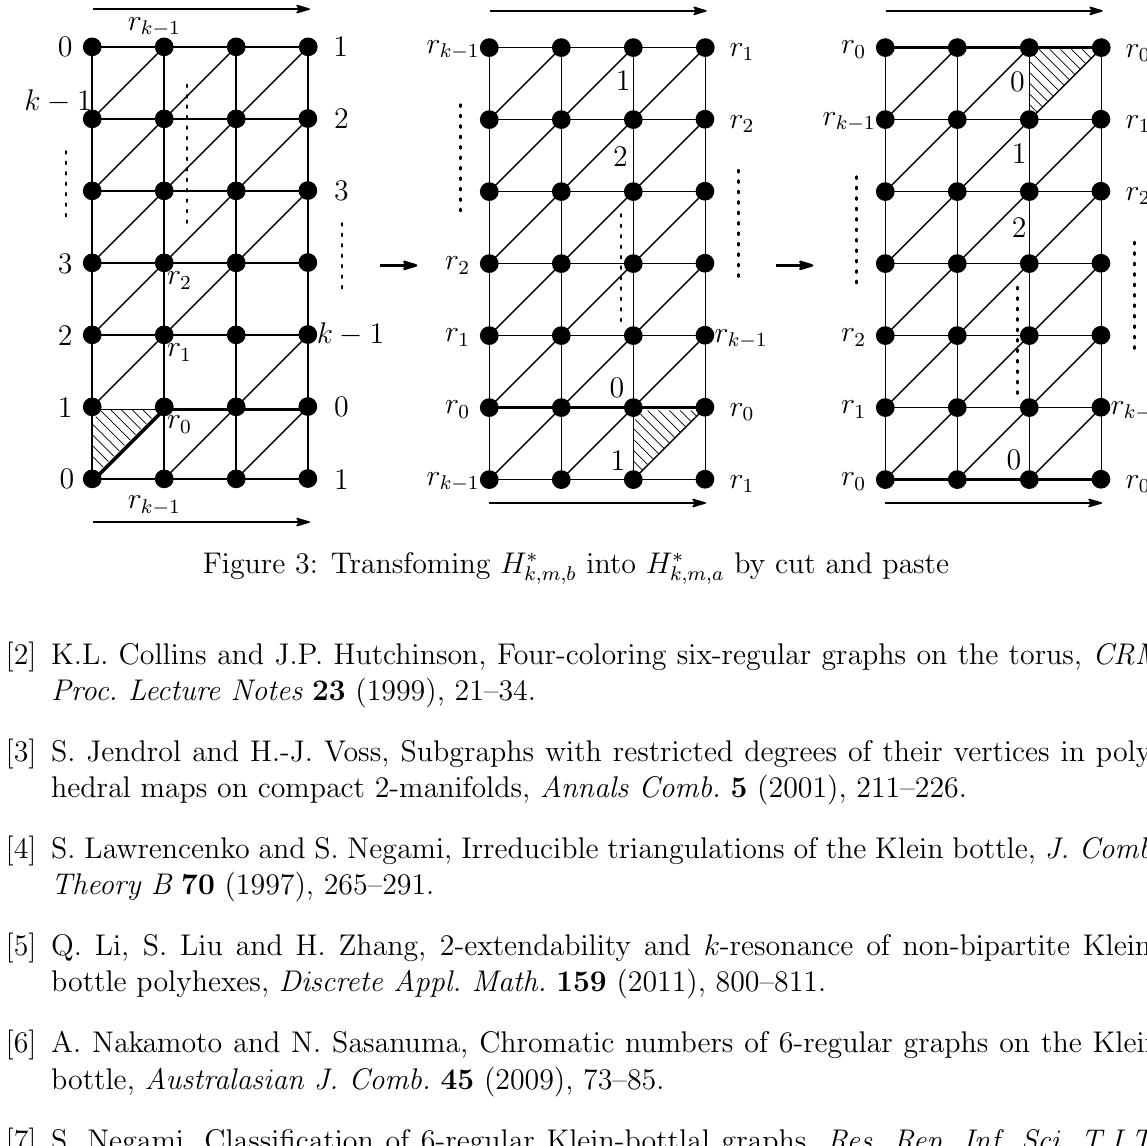
Figure 3: Transfoming H (cid:3)